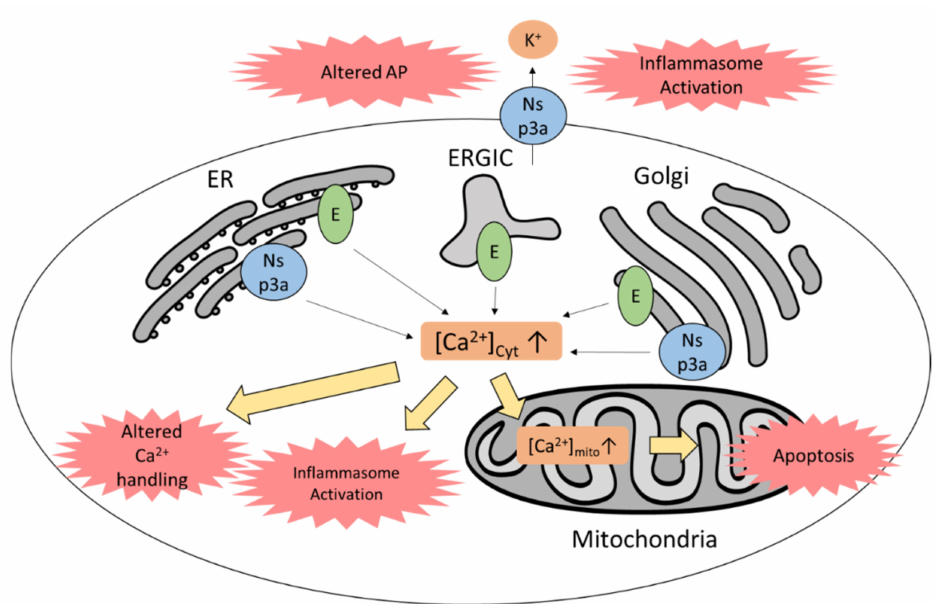
Figure 9. SARS-CoV-2 proteins form cationic viroporins, causing inflammasome activation, altered action potential and Ca 2+ handling, and apoptosis. ER, endoplasmic reticulum; ERGIC, ER–Golgi intermediate compartment; AP, action potential; cyt, cytosolic; mito,